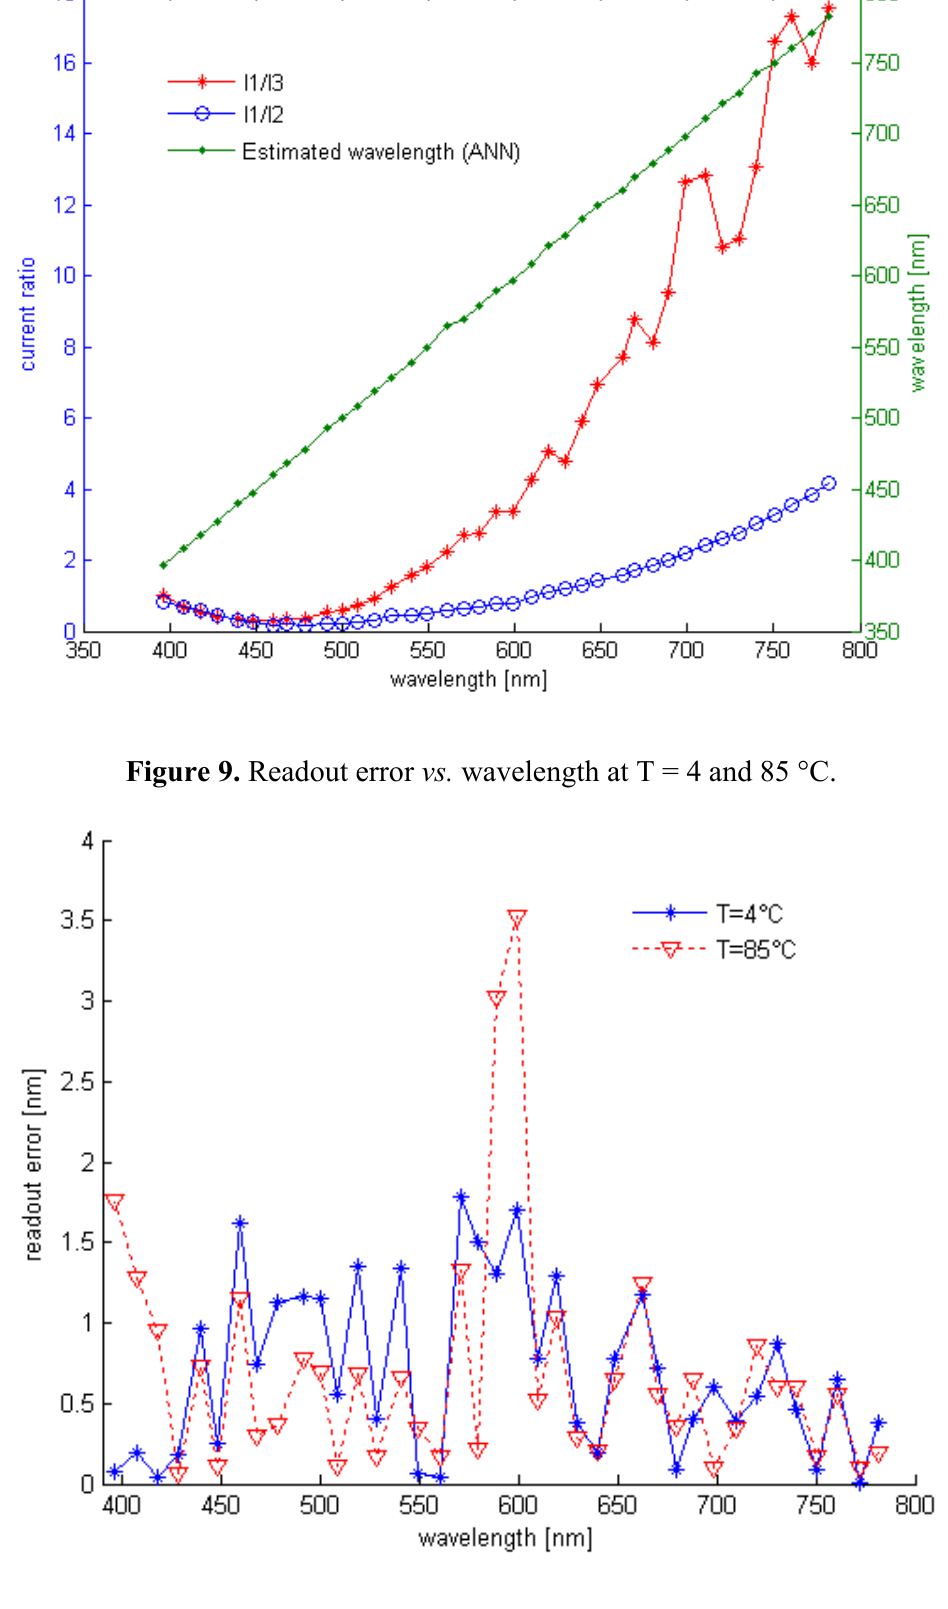
/I and I /I vs. applied wavelength. 1 2 1 3